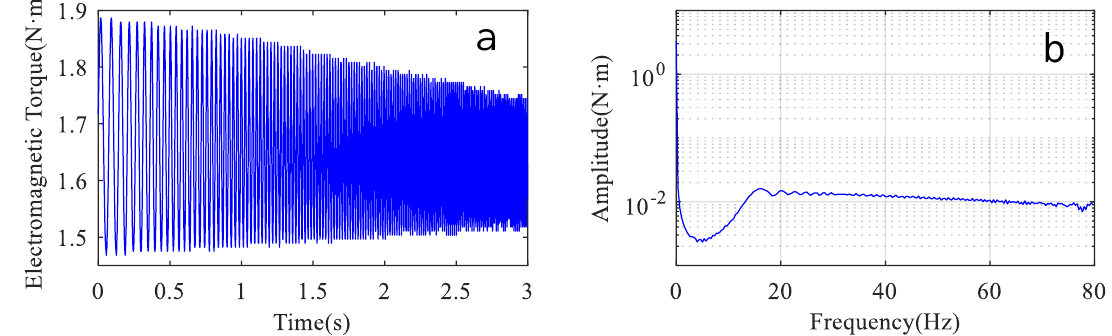
Figure 11. Motor electromagnetic torque waveform and frequency spectrum. ( a ) waveform of the signal; ( b ) spectrum of the signal.